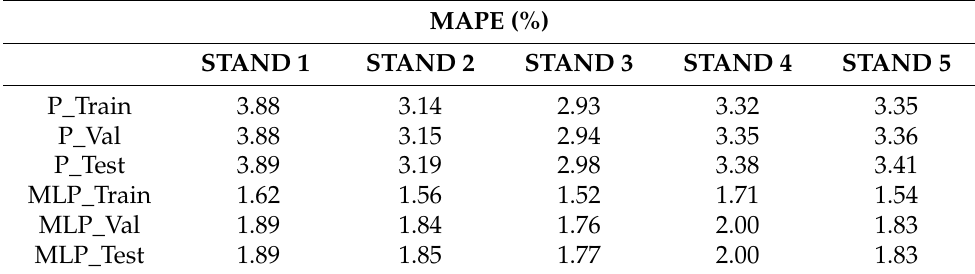
Table 12. Comparison of the roll force prediction using MAPE.